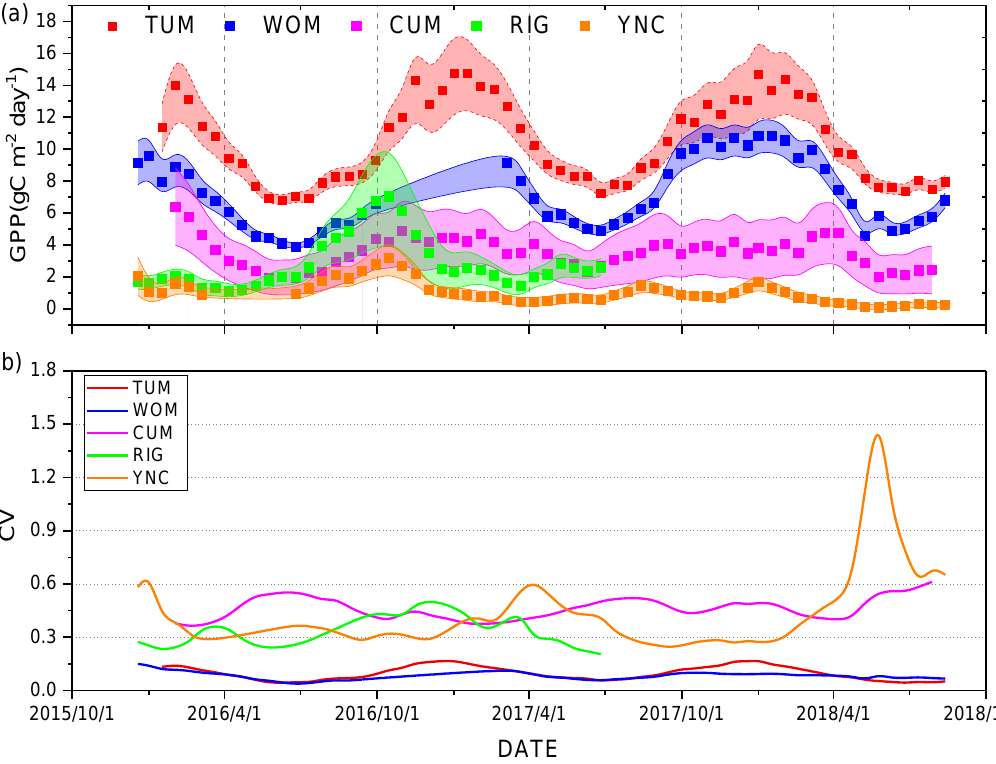
Figure 9. Temporal trends in the coefficient of variance (CV = STD/mean value) of GPP at the five research sites. The solid points in subfigure ( a ) are the mean GPP values in the footprint regions on different dates, whereas the shaded areas represent one standard deviation around the mean prediction. Each curve in subfigure ( b ) is the CV of GPP on each date.